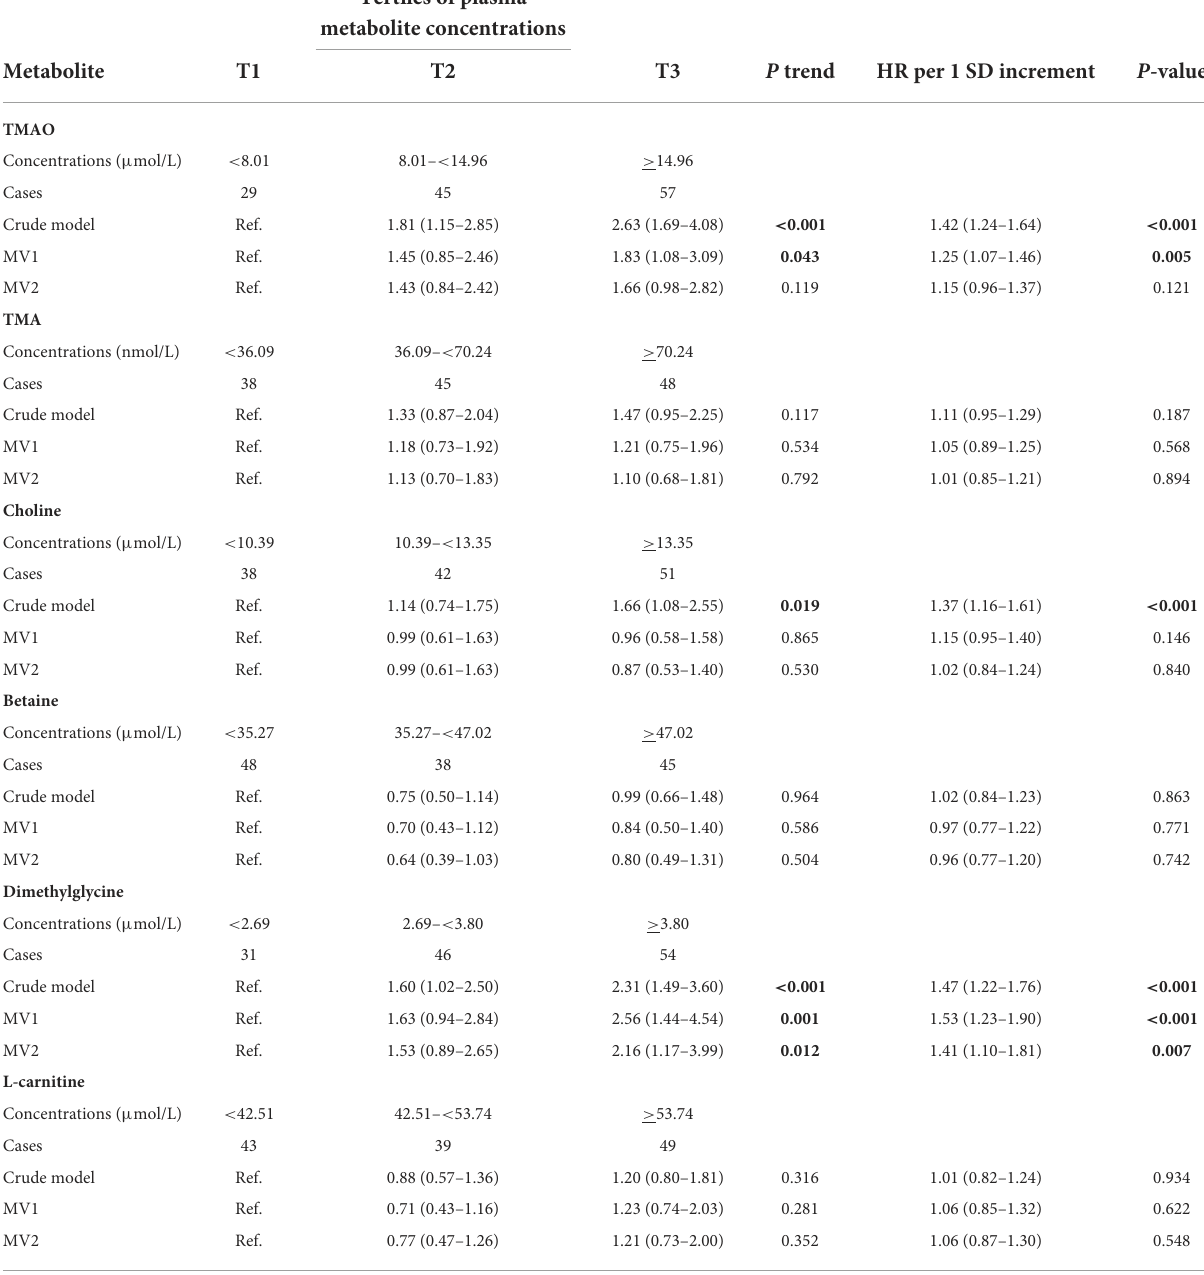
TABLE 2 Associations of baseline individual metabolites concentrations with the risk of MACE a . Tertiles of